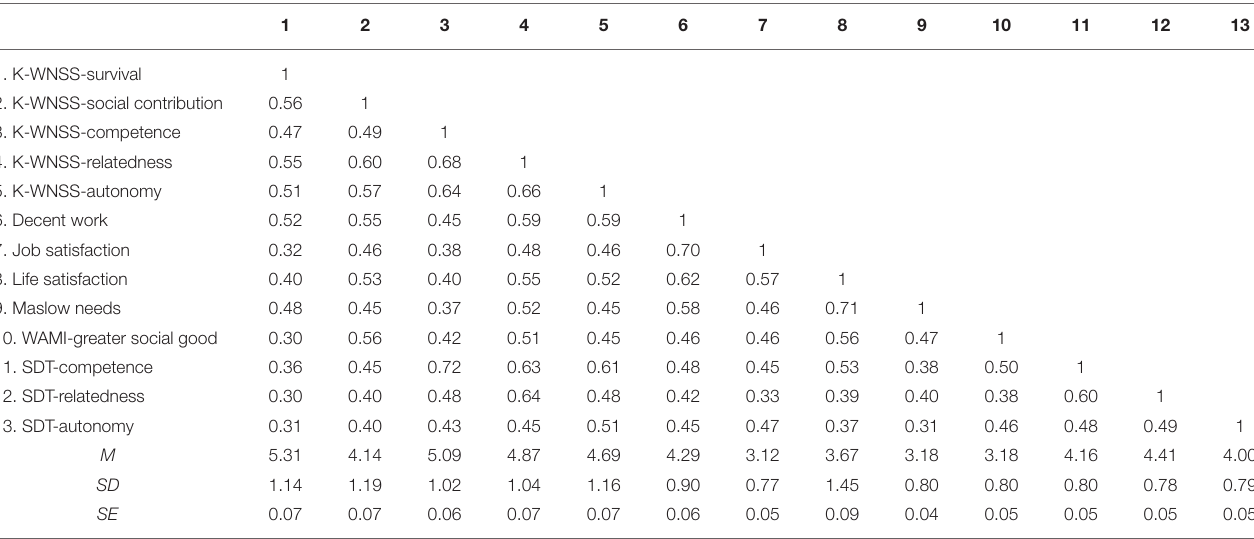
TABLE 4 | Descriptive data and bivariate correlations for variables used ( N = 250 ).